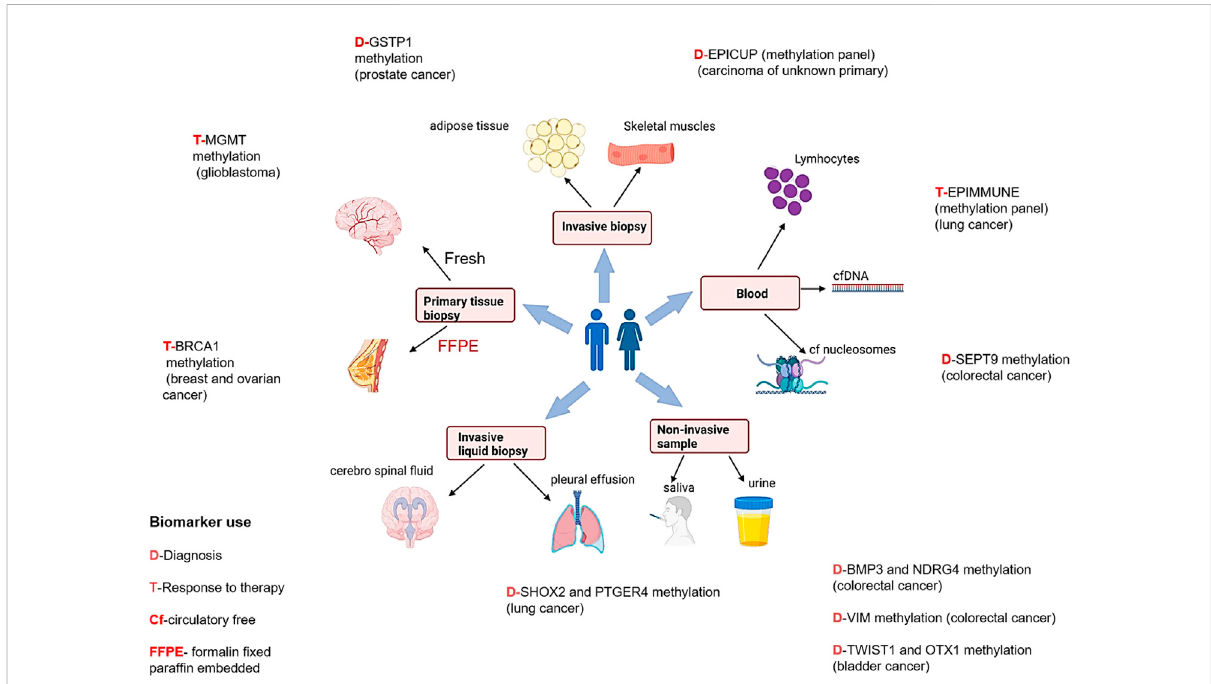
FIGURE 3 Epigenetic biomarkers and different sample types for diagnosis, prognosis, and treatment therapies in different cancers [Icons were created by Biorender.com (accessed on January 28th